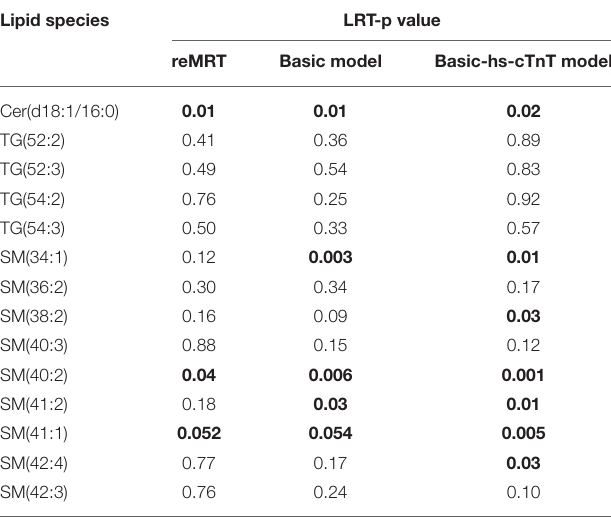
TABLE 5 | Significance of the incremental values of selected lipids over the re-estimated minimal risk tool (reMRT) and the two alternative baseline models for the purpose of sensitivity analysis.